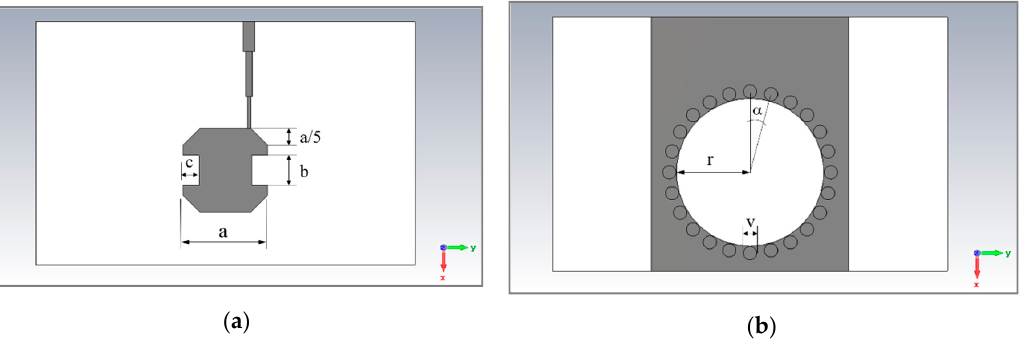
Figure 3. Layout of SIW cavity-backed patch antenna. ( a ) Top view of the patch antenna and ( b ) top view of the SIW circular resonant cavity. Table 1. List of the geometric parameters of the SIW cavity-backed patch antenna.